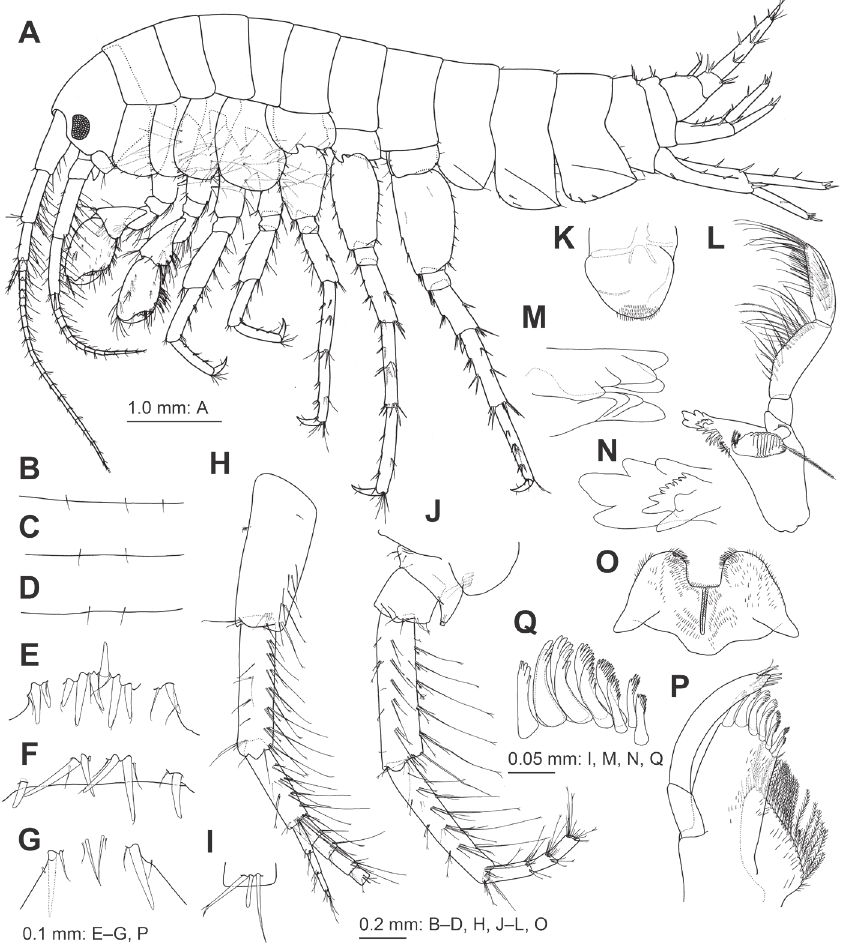
Figure 3. Jesogammarus ( Jesogammarus ) acalceolus sp. nov., male (7.4 mm), NSMT-Cr 29003 A habitus, lat- eral view B–D dorsal margins of pleonites 1–3, respectively, dorsal views E–G dorsal margins of urosomites 1–3, respectively, dorsal views H peduncular articles 1–3, accessory flagellum, and flagellar articles 1–4 of an- tenna 1, medial view I aesthetasc and associate setae on the flagellum of antenna 1, medial view J peduncular articles 1–5 and flagellar articles 1–3 of antenna 2, medial view K upper lip, posterior view L right mandible, medial view M–N incisor and lacinia mobilis of left and right mandibles, medial views O lower lip, ventral view P maxilla 1, medial view Q serrate robust setae on outer plate of maxilla 1, medial